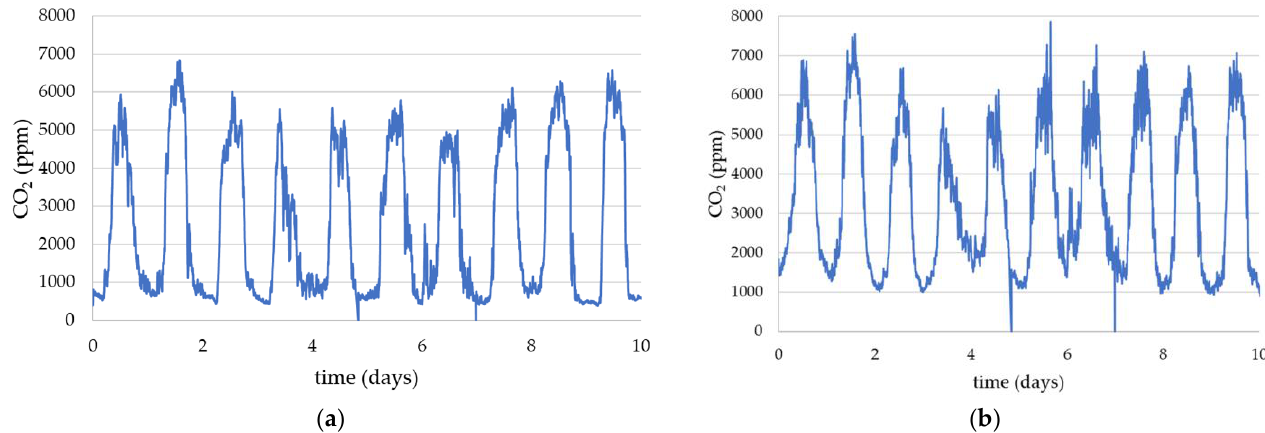
Figure 3. CO 2 data from HPP8 measured at a sensor in the crown board ( a ) and the queen excluder ( b ) covering the same measurement times.